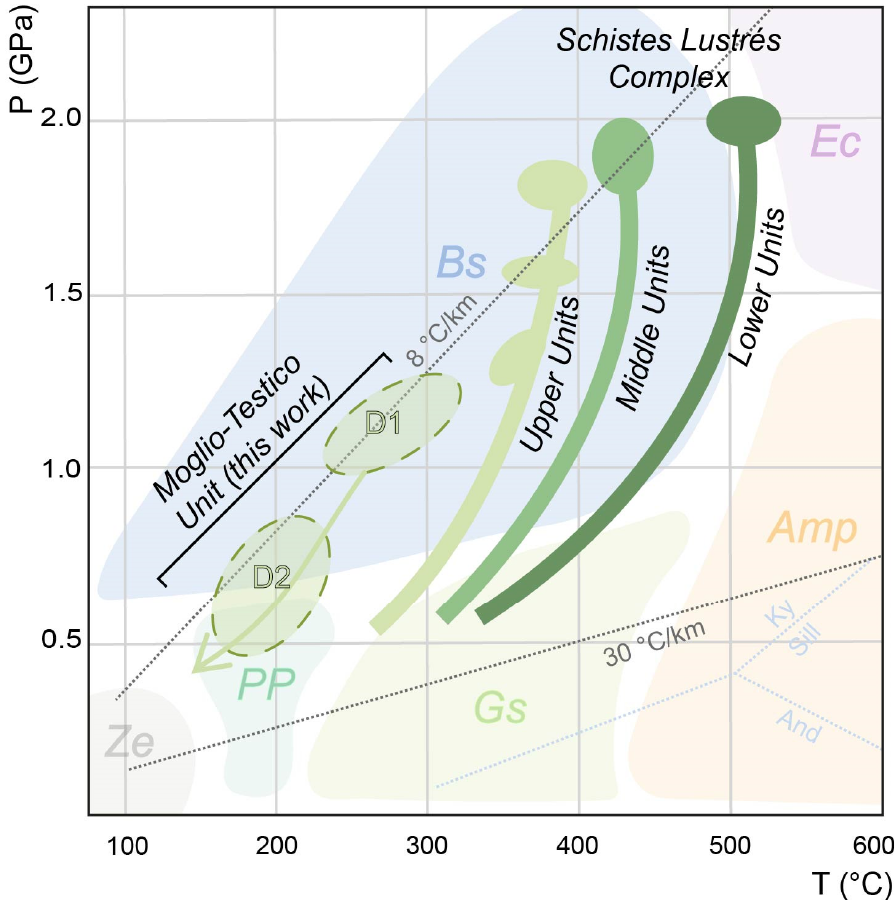
Figure 11. P–T path of the Moglio-Testico Unit (pale green thin arrow in the P/T space) obtained in this work. The P–T paths related to the oceanic-derived units exposed along the Western Alps are also reported (thick green lines in the P/T space, Schistes Lustrés complex data from [3,6,36,42]). The green elliptic areas indicate the point clouds reported in the P/T diagram of Figure 10.